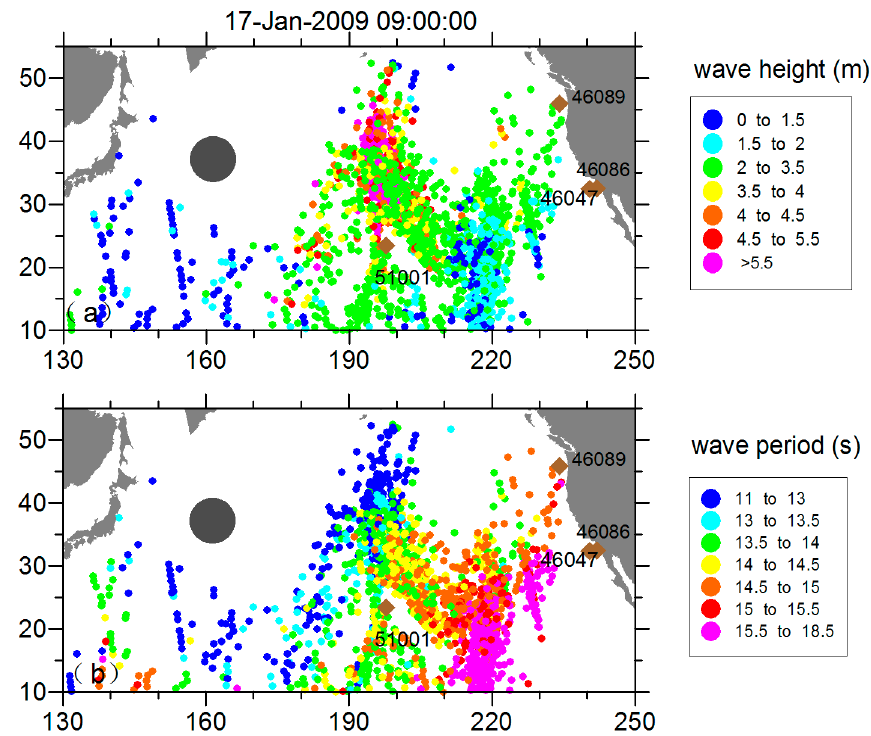
Figure 1. The “fireworks” of propagated swells at 17-Jan-2009 09:00:00.